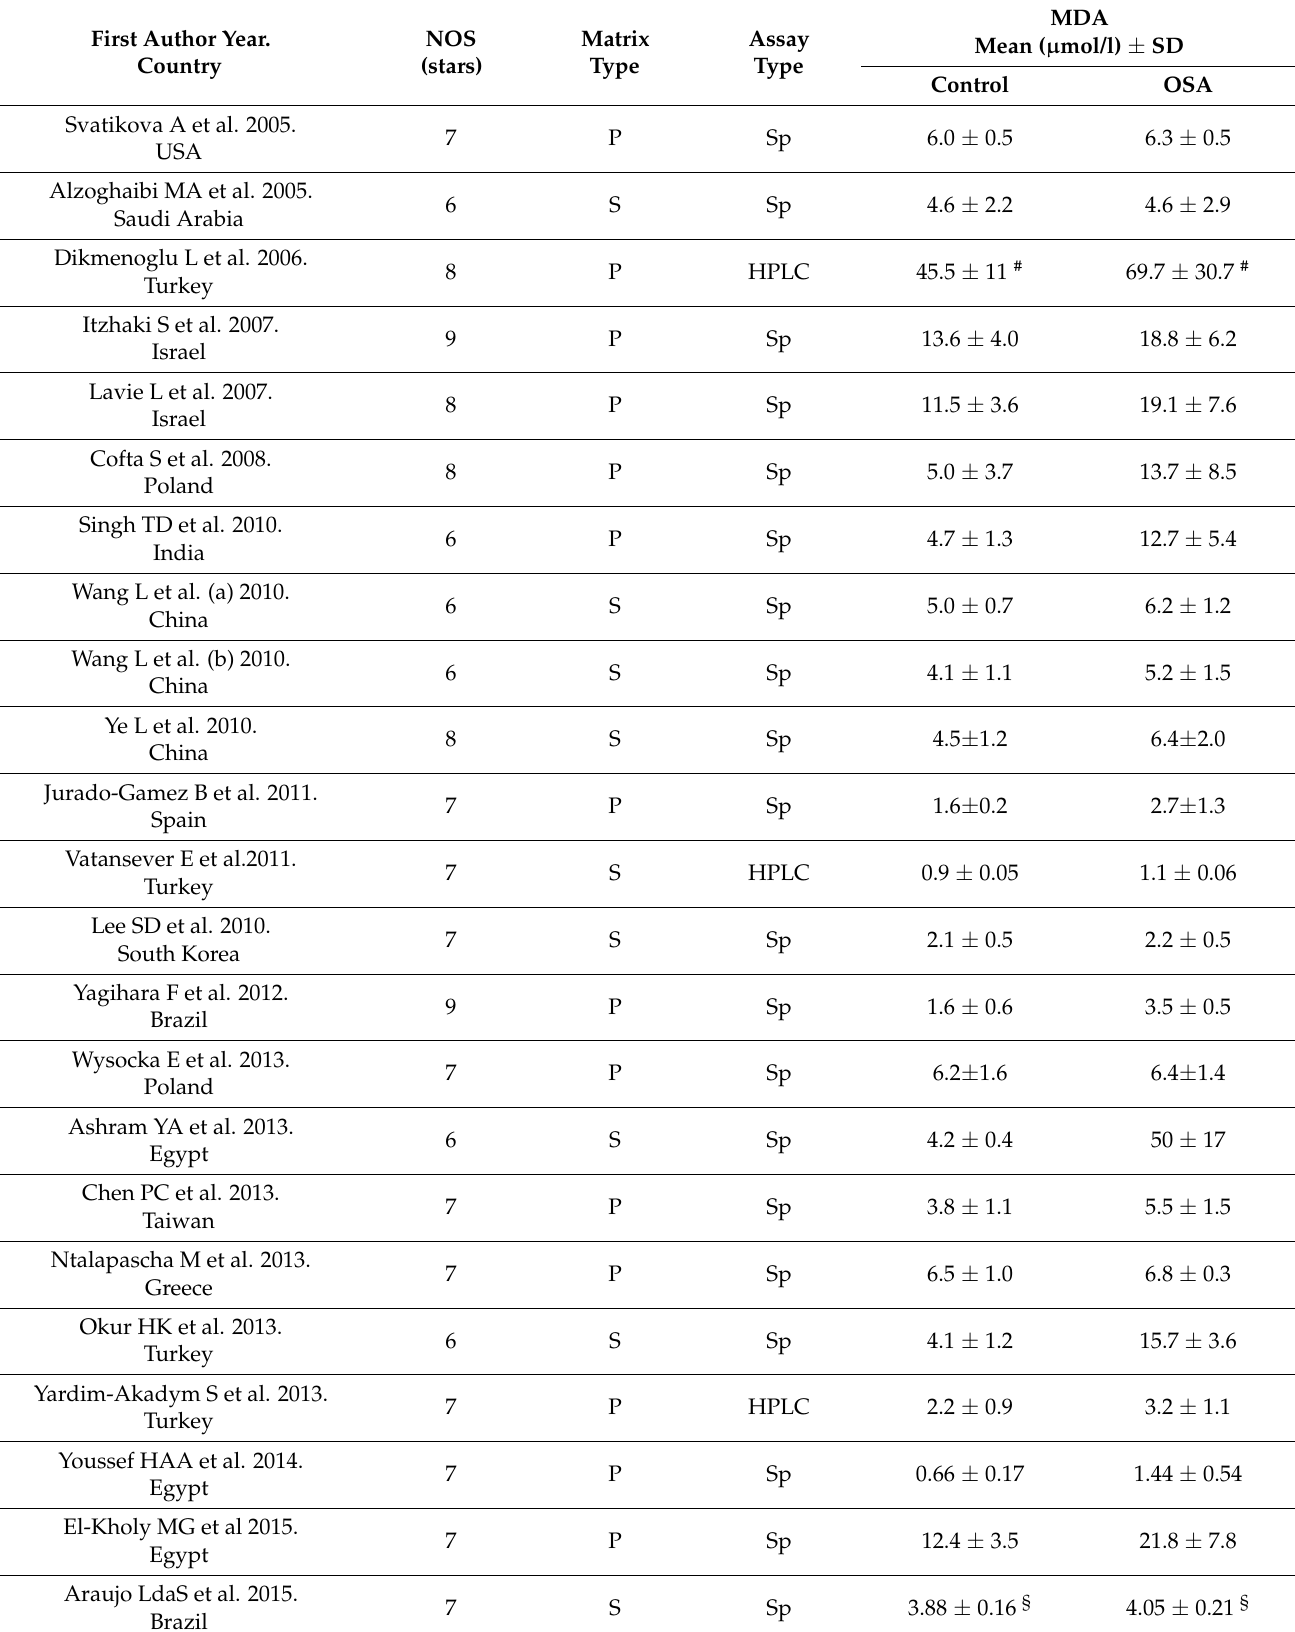
Table 2. MDA concentrations in the studies included in the